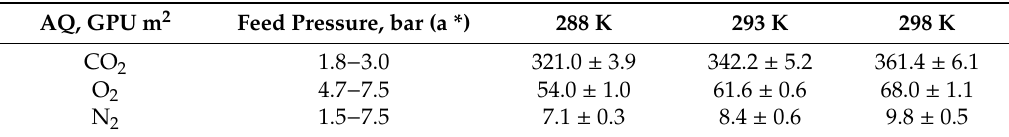
Table 2. Module permeance of carbon dioxide, nitrogen, and oxygen in Air Products PRISM PA1020.